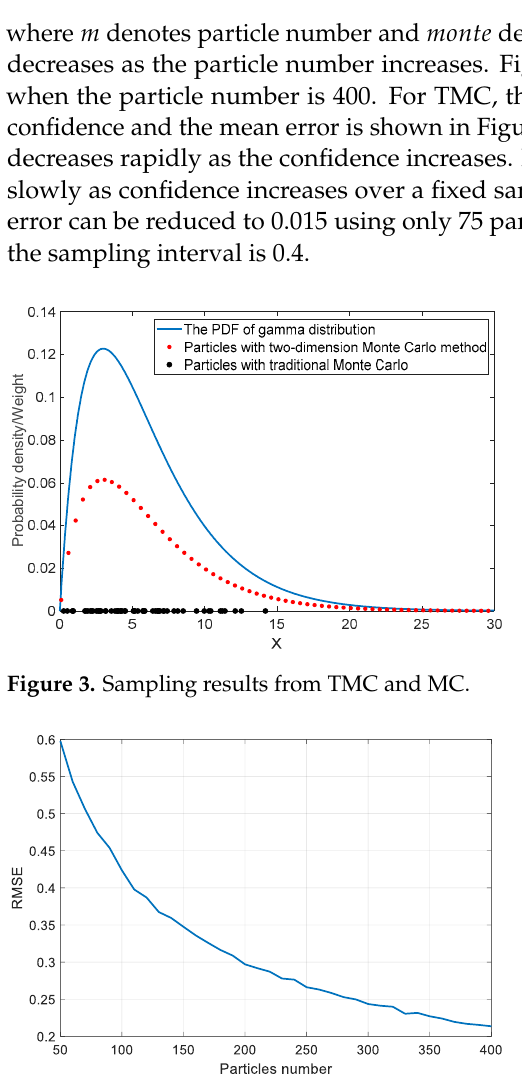
Figure 4. Variation of the expectation RMSE with the particle number for MC.